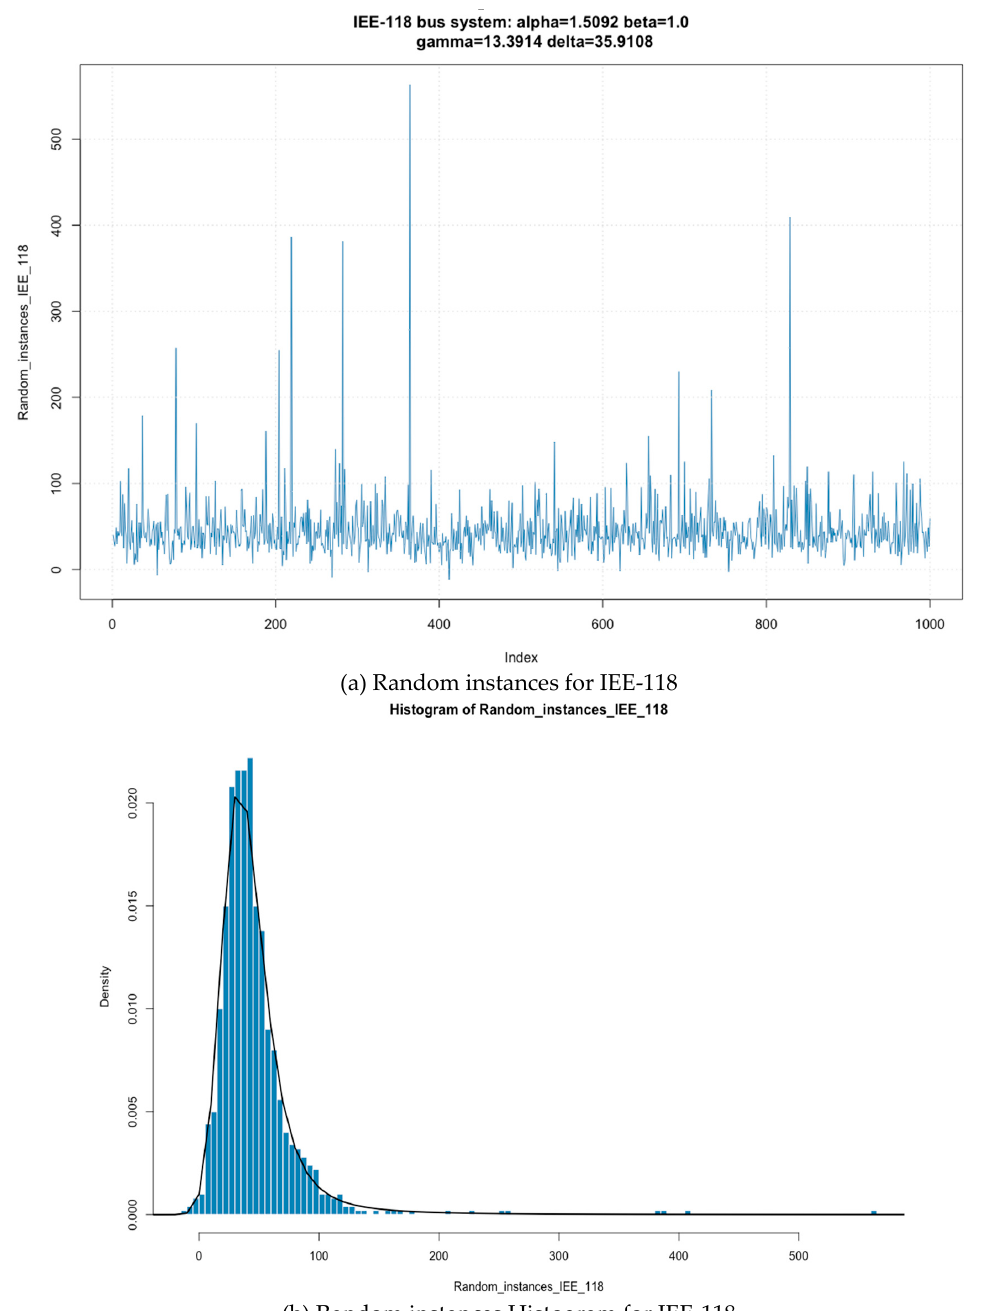
Figure 4. IEEE-118 bus system simulations.